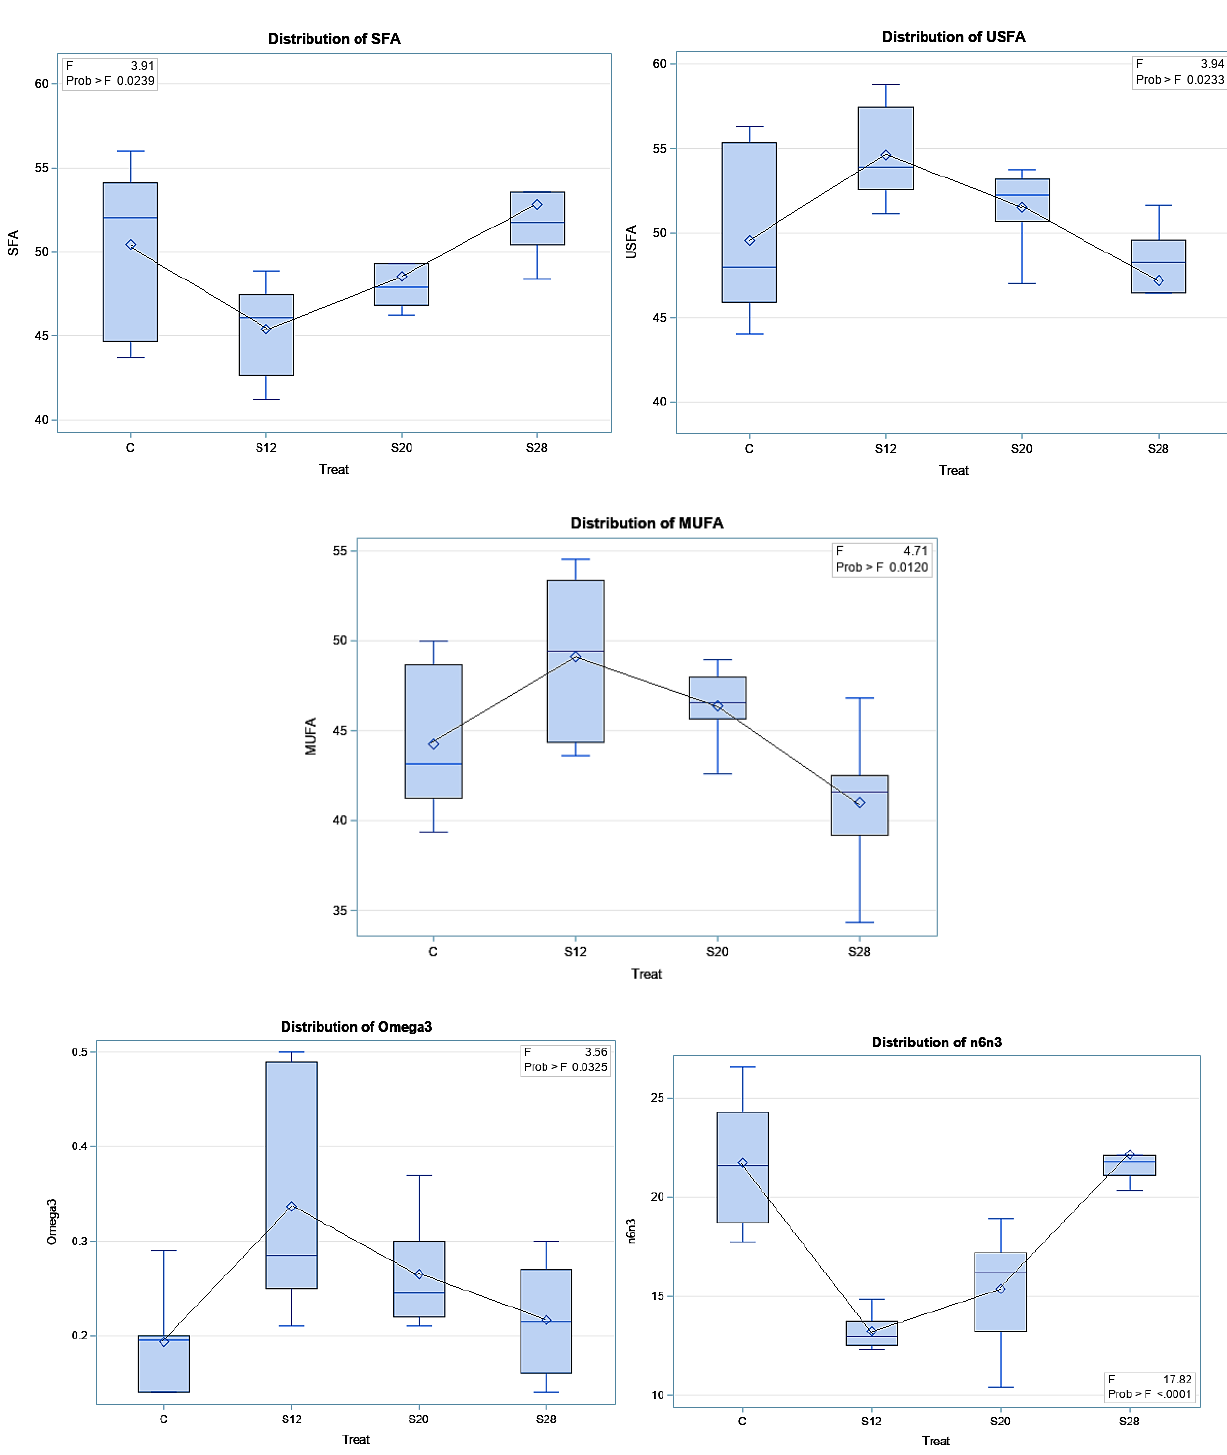
Figure 5. The effect of different levels of sunflower hulls on colostrum fatty acid indices (i.e., saturated fatty acids, SFA; unsaturated fatty acids, USFA; monounsaturated fatty acids, MUFA; omega3; and SFA/USFA, saturated fatty acids per unsaturated fatty acids; omega6/omega3, n6/n3), as assessed via the regression analysis.